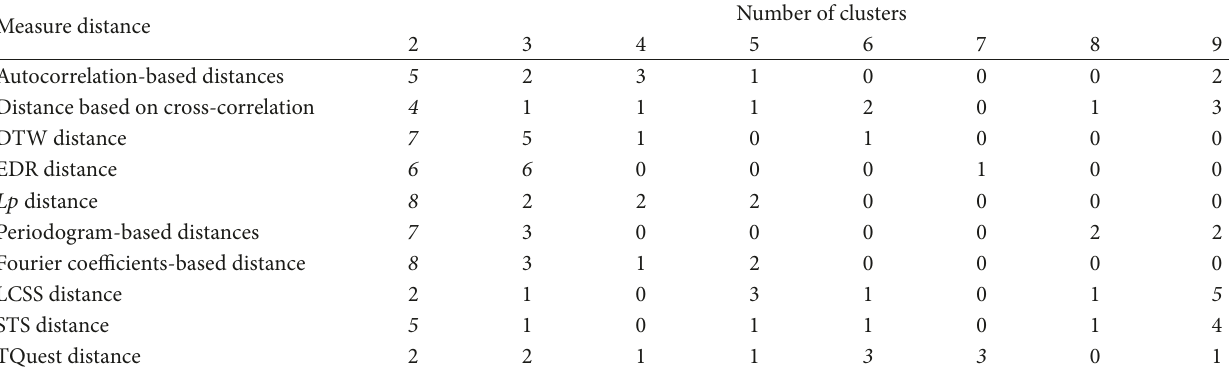
Table 4: Voting results for the relevant number of clusters based on the partition type and the time series similarity measure. Measure distance Autocorrelation-based distances Distance based on